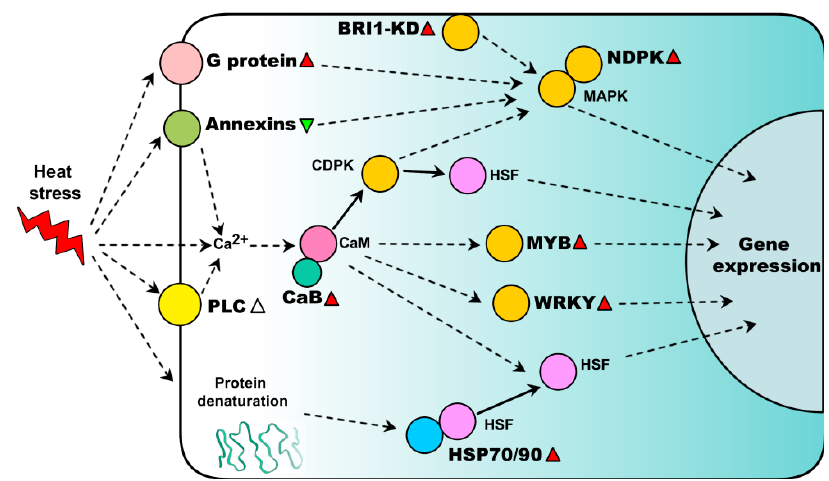
Figure 1. Schematic representation of heat-responsive proteins involved in signal transduction pathway. Heat stress results in an inward flux of calcium and activation of G protein by phospholipase C (PLC), annexins and other proteins. Calcium binds the calmodulin (CaM) and calcium-binding protein (CaB), and then activates multiple kinases (e.g., CDPK and MAPK) and transcriptional regulators (e.g., MYB, WRKY and HSF). HSP70 and HSP90 negatively regulate the activity of HSFA1. BRI1-KD and annexin participate in the heat signal transduction through MAPK-activated stress response. Red and green triangles represent heat-increased and heat-decreased abundance of proteins, respectively. White triangle represents heat-increased phosphorylation level. Partly adopted from Mittler et al. [52].